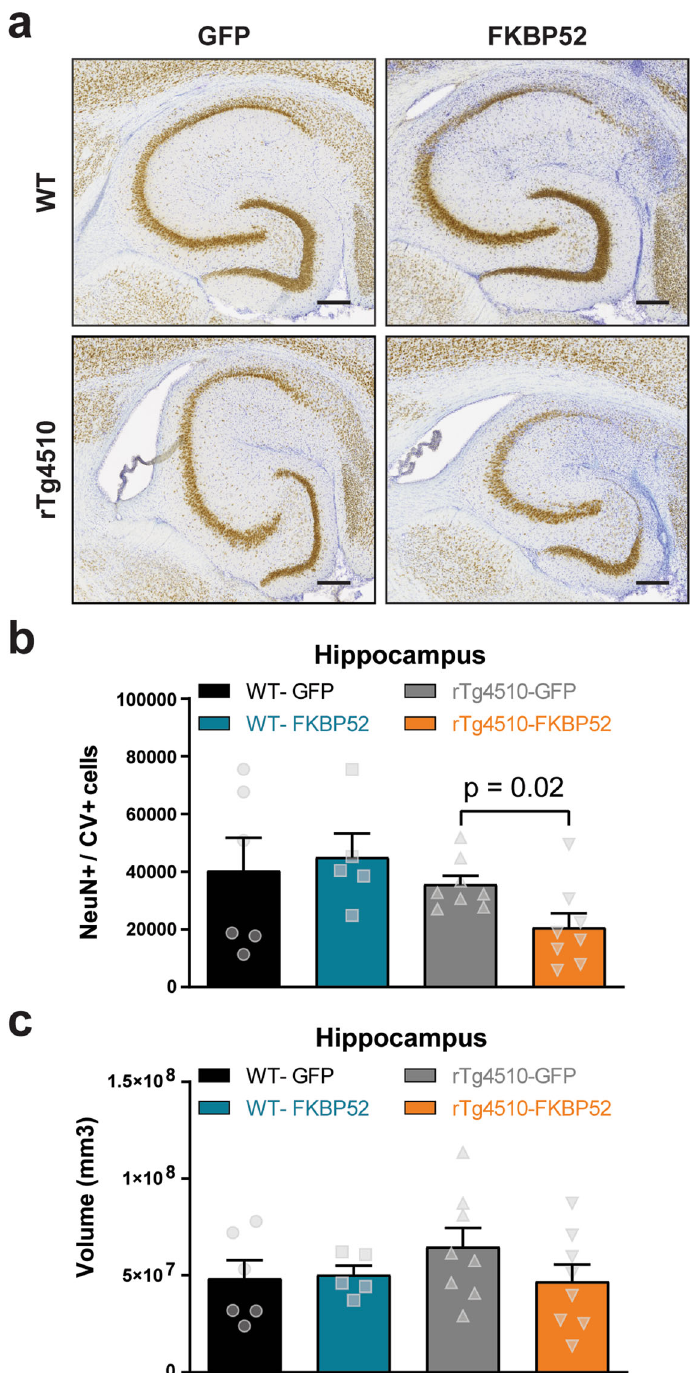
Fig. 8 FKBP52 signi fi cantly affects neuronal density in tau transgenic mice. a Representative images from hippocampal neurons stained with NeuN (brown) and cresyl violet (CV, purple). These hippocampal slices correspond to AAV9-GFP and AAV9-FKBP52 injected mice. b Quanti fi cation of unbiased stereology from these animals. Results represent the standard error of the mean (±SEM). Data were analyzed by a two-way ANOVA and Bonferroni tests. Statistical difference in neuronal loss between rTg4510-GFP ( n = 8) and rT4510-FKBP52 ( n = 8) mice was evaluated by an independent t test ( p = 0.02). c Hippocampal volume quanti fi ed by unbiased stereology. WT-GFP ( n = 6) and WT-FKBP52 ( n = 5). Scale bars are 200 μ m. GFP green fl uorescent protein, WT wild-type, mm 3 cubic